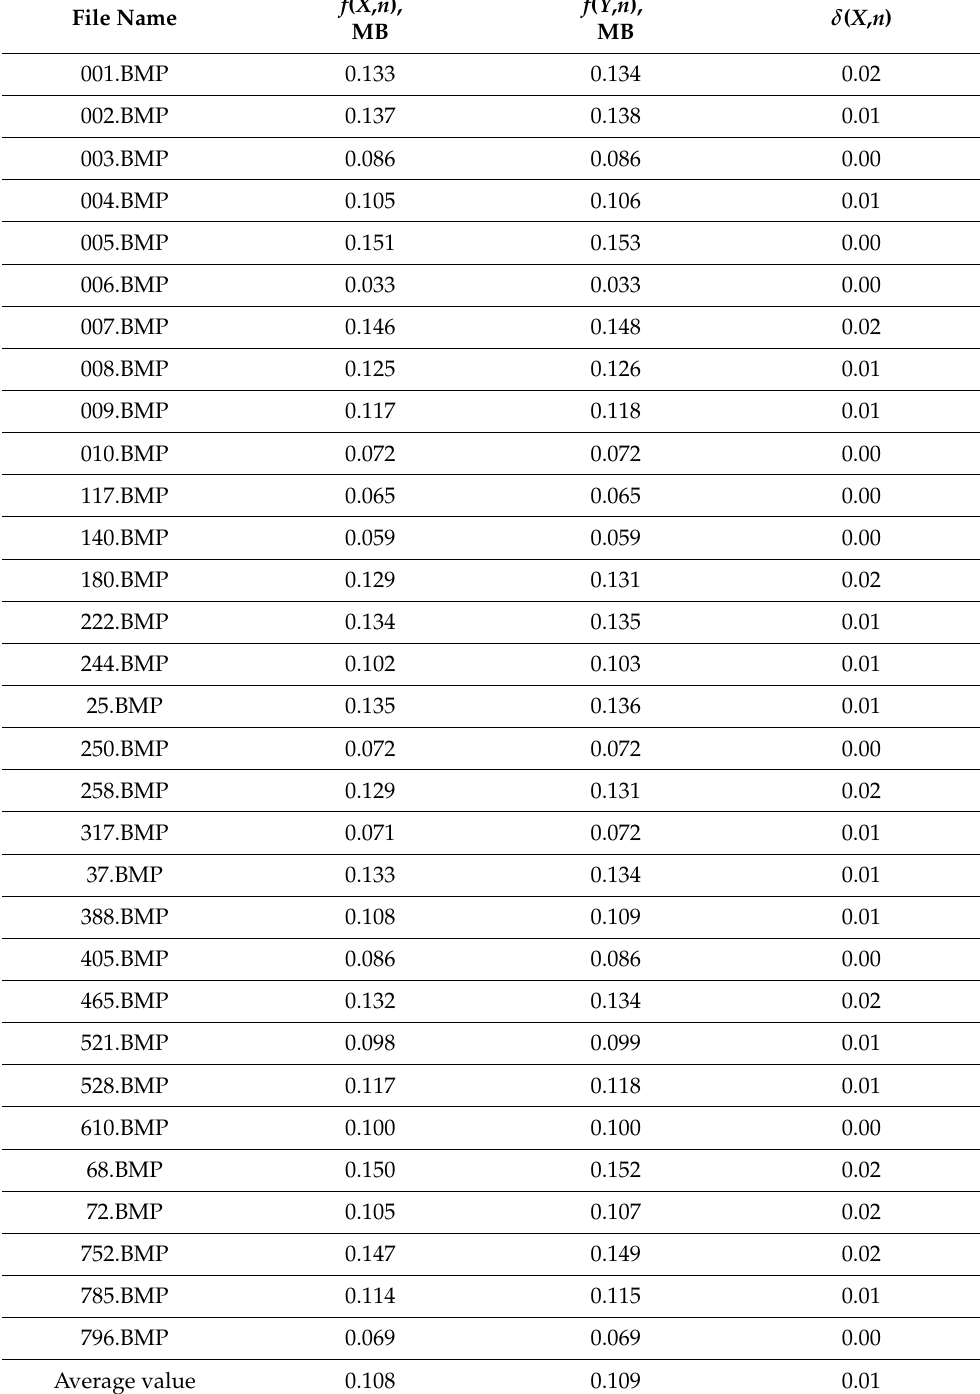
Table 5. Comparison of differences in compression ratios for empty and filled